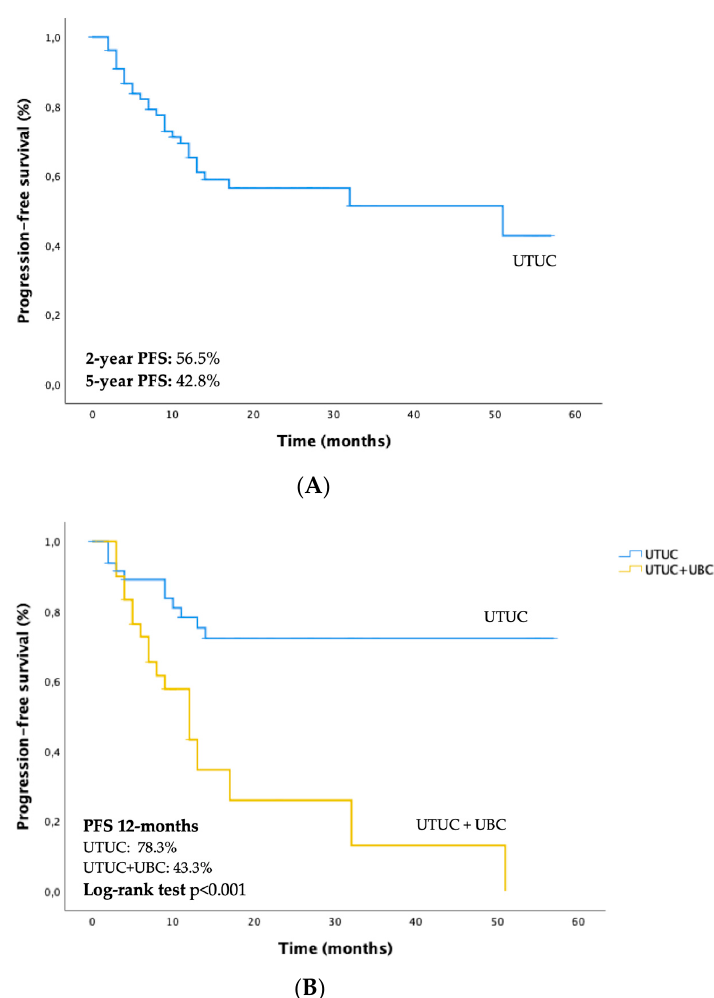
Figure 1. Kaplan–Meier curves for progression-free survival (PFS) of patients with UTUC ( A ) and stratified according to the two subgroups—only UTUC (blue line) vs. UTUC + UBC (yellow line) ( B ). Abbreviations: UBC—urothelial bladder cancer; UTUC—upper tract urothelial carcinoma.